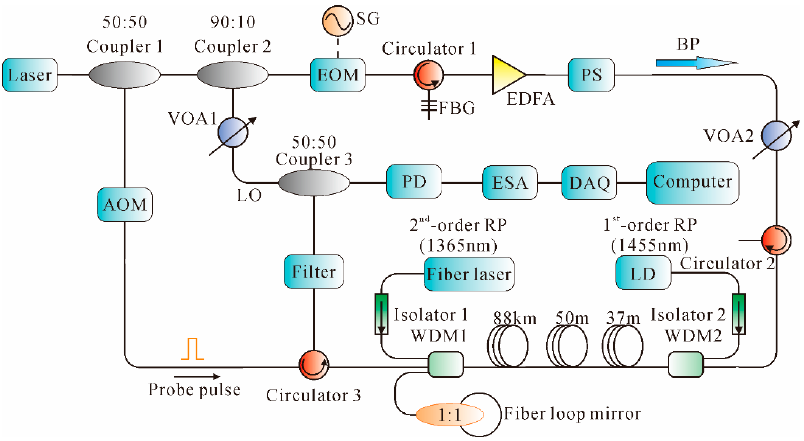
Figure 12. Experimental setup for ultra-long Φ -OTDR utilizing a novel hybrid amplification scheme, adapted from Wang et al.